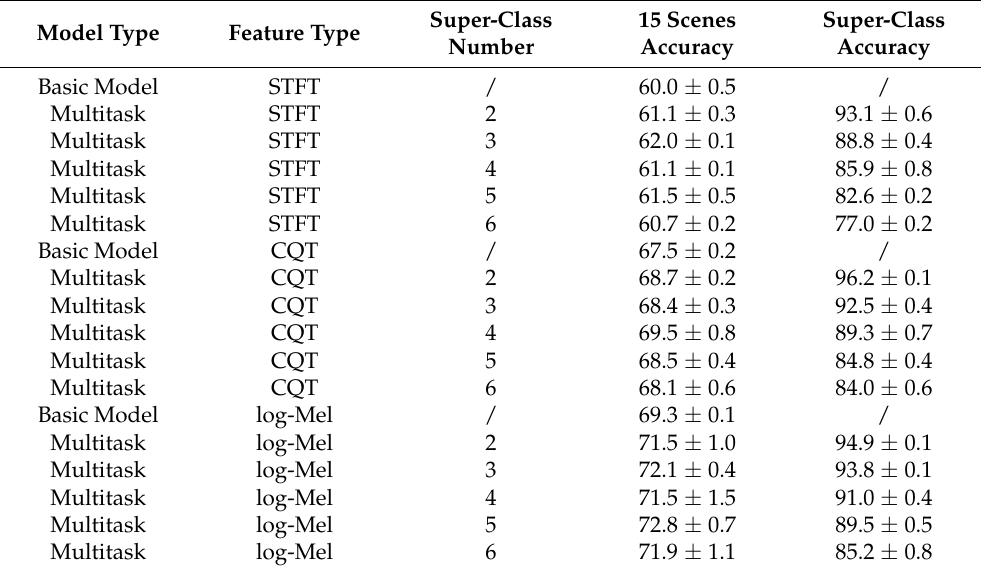
Table 3. Classification performance of the TUT Acoustic Scenes 2017 dataset using different